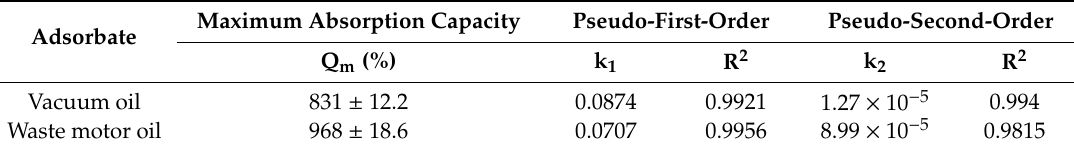
Figure 11. Pseudo-first-order and pseudo-second-order absorption linear fitting of the vacuum oil and waste motor oil onto SCA. Table 3. Summary of the maximum oil absorption capacities and the absorption rate constants of the SCA using the pseudo-first-order and pseudo-second-order